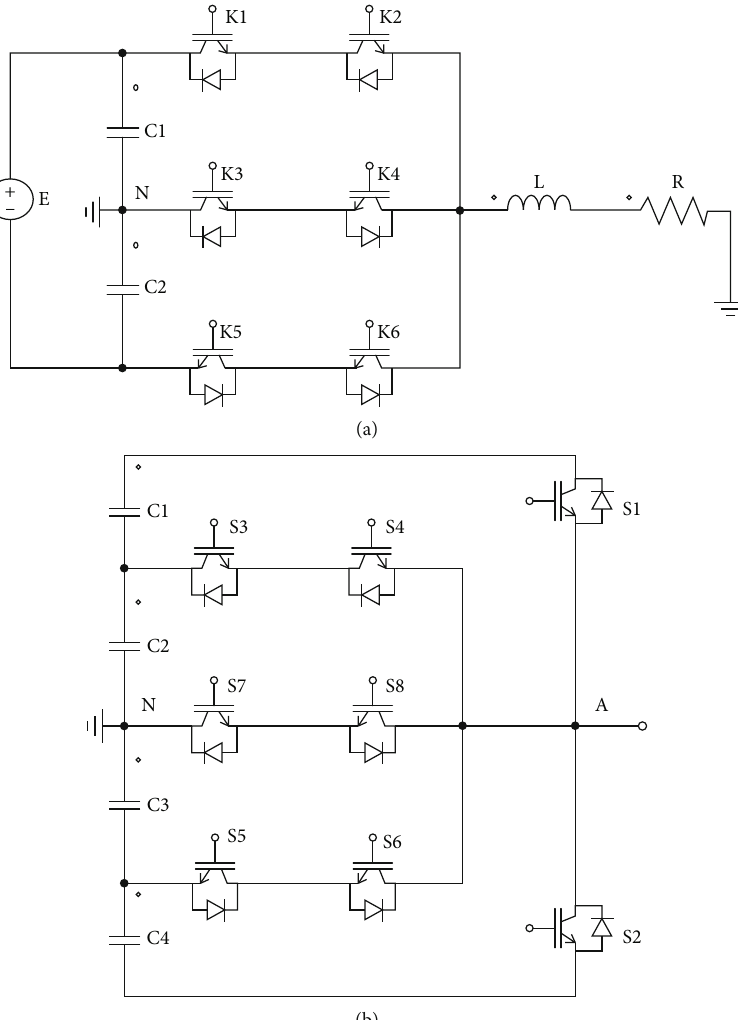
Figure 1: (a) Single-phase multicellular model with three levels and (b) existing ANPC inverter.